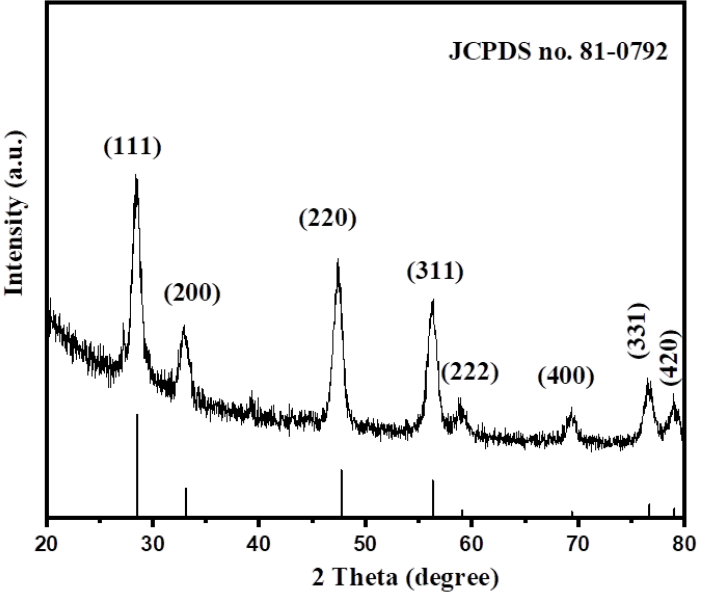
Figure 1. PXRD pattern of the synthesized CeO 2 .